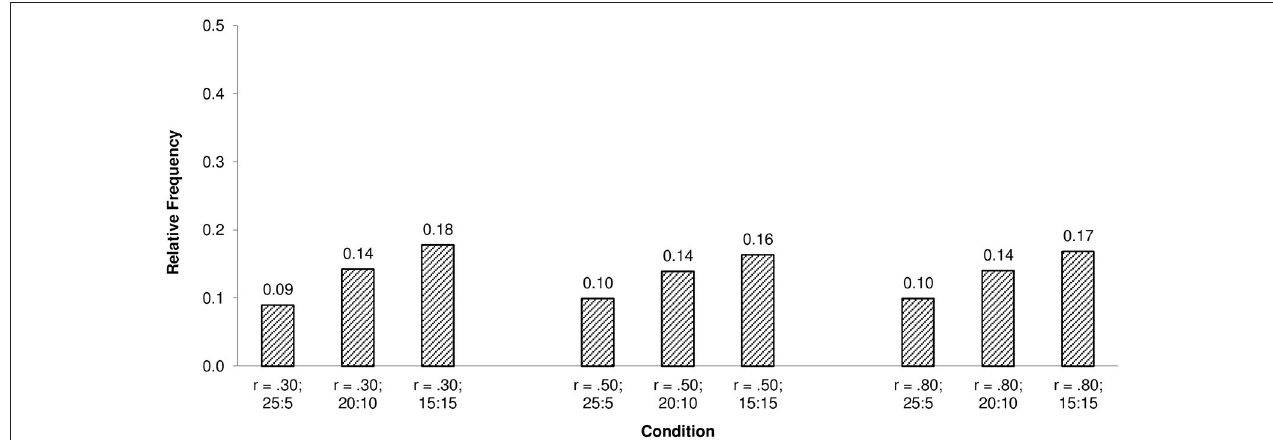
FIGURE 2 | Relative frequencies of proportions correct within their 95% confidence interval for the ISOP model and N = 250.